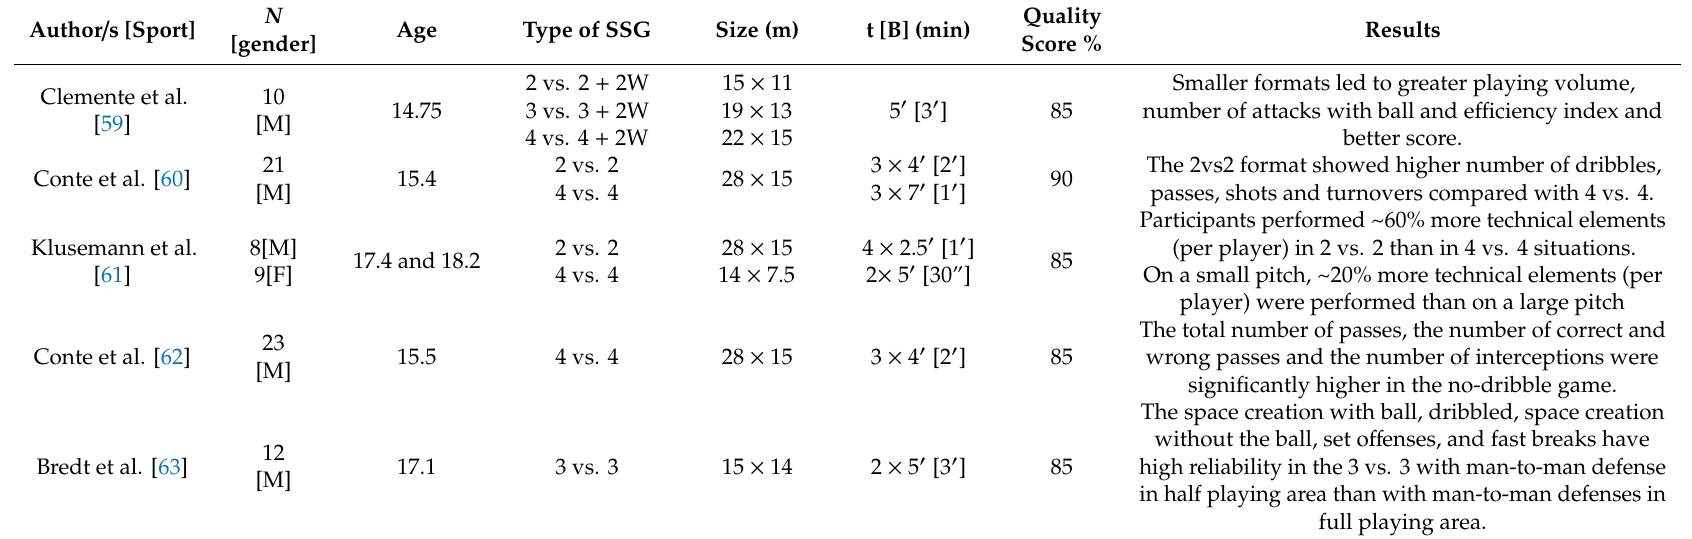
Table 2. E ff ects of SSGs on technical-tactical aspects in basketball.